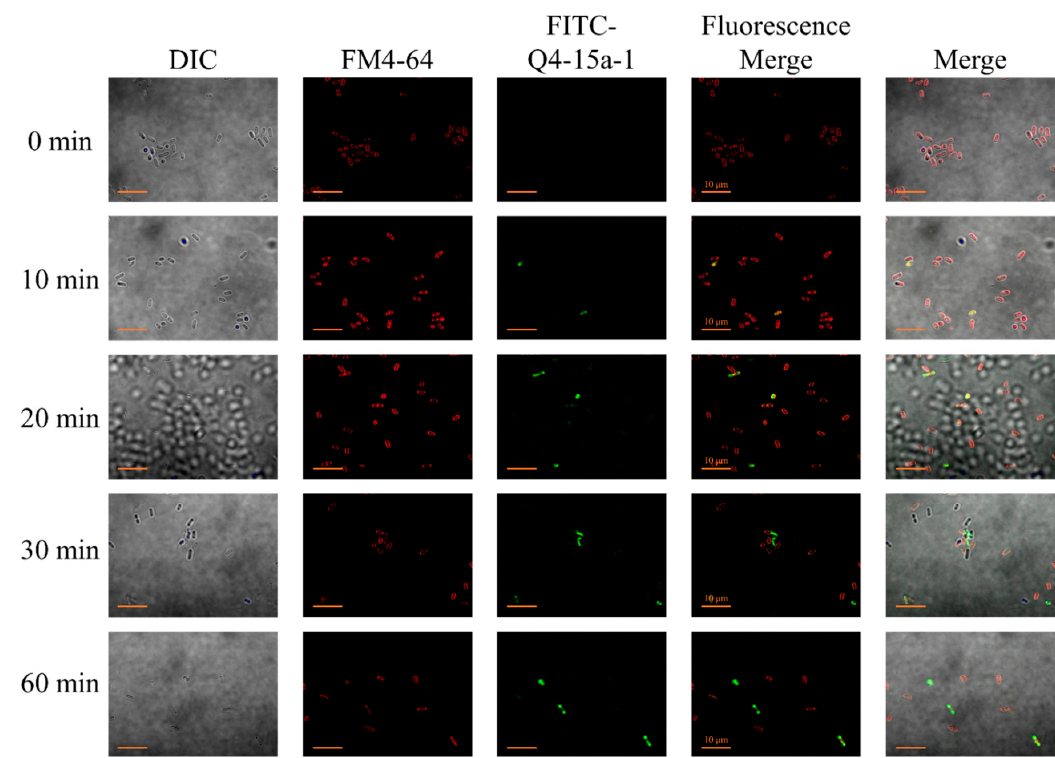
Figure 3. Localization of FITC-Q4-15a-1 in multidrug-resistant enterotoxigenic Escherichia coli (MDR ETEC) at different time intervals monitored by confocal microscopy. Bar: 10 μ m.